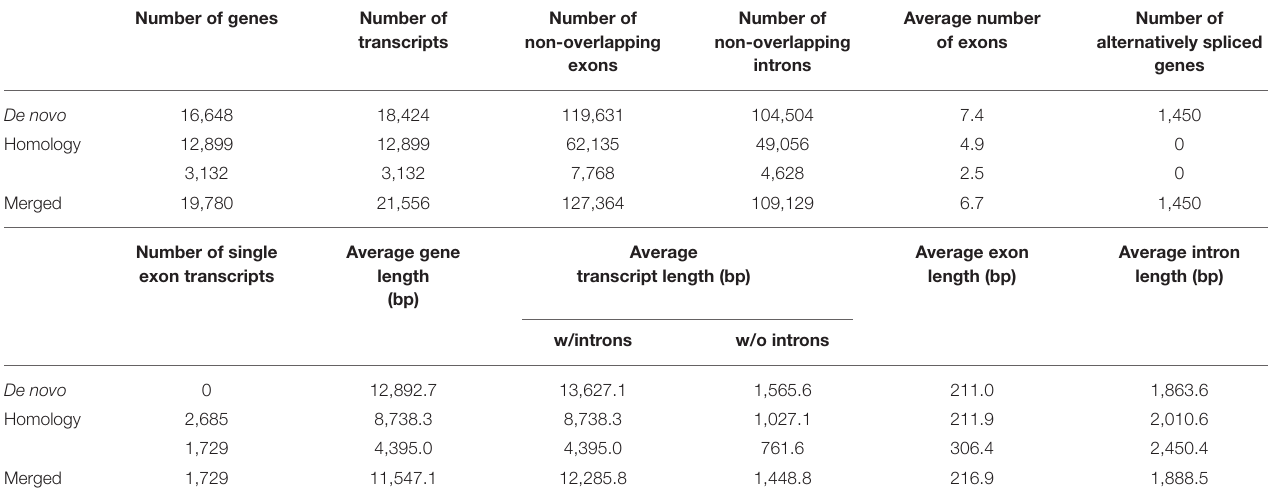
( Supplementary Table 4 ). Three bacterial scaffolds and one adapter contaminated scaffold were detected and removed during NCBI submission process ( Table 1 ).